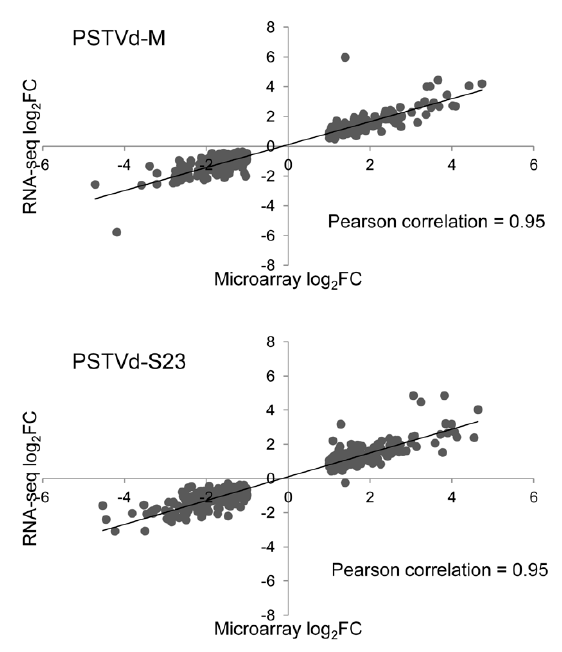
Figure 8. Correlation of microarray and RNA-seq data for DEGs identified by both analysis.